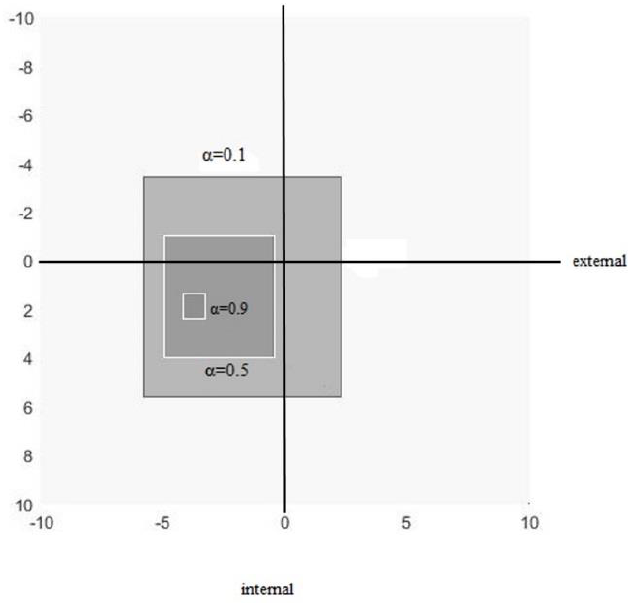
Figure 13. Fuzzy areas for α = 0.1, 0.5,0.9 .